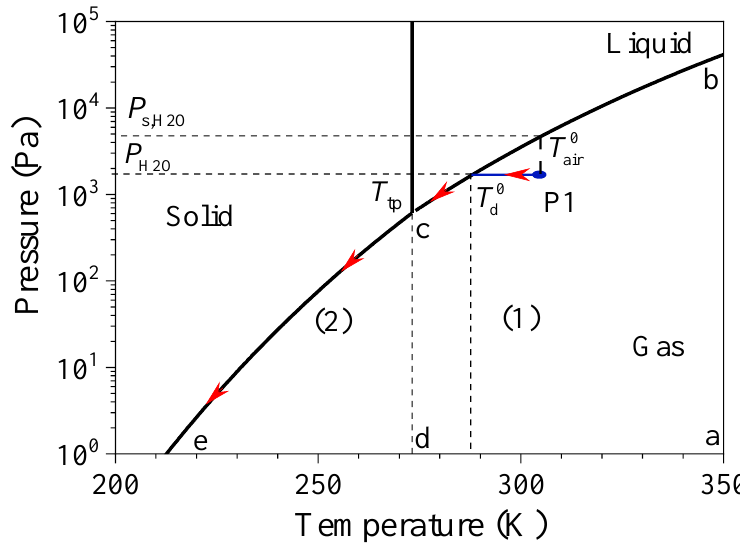
Figure 2. P-T phase diagram of water.